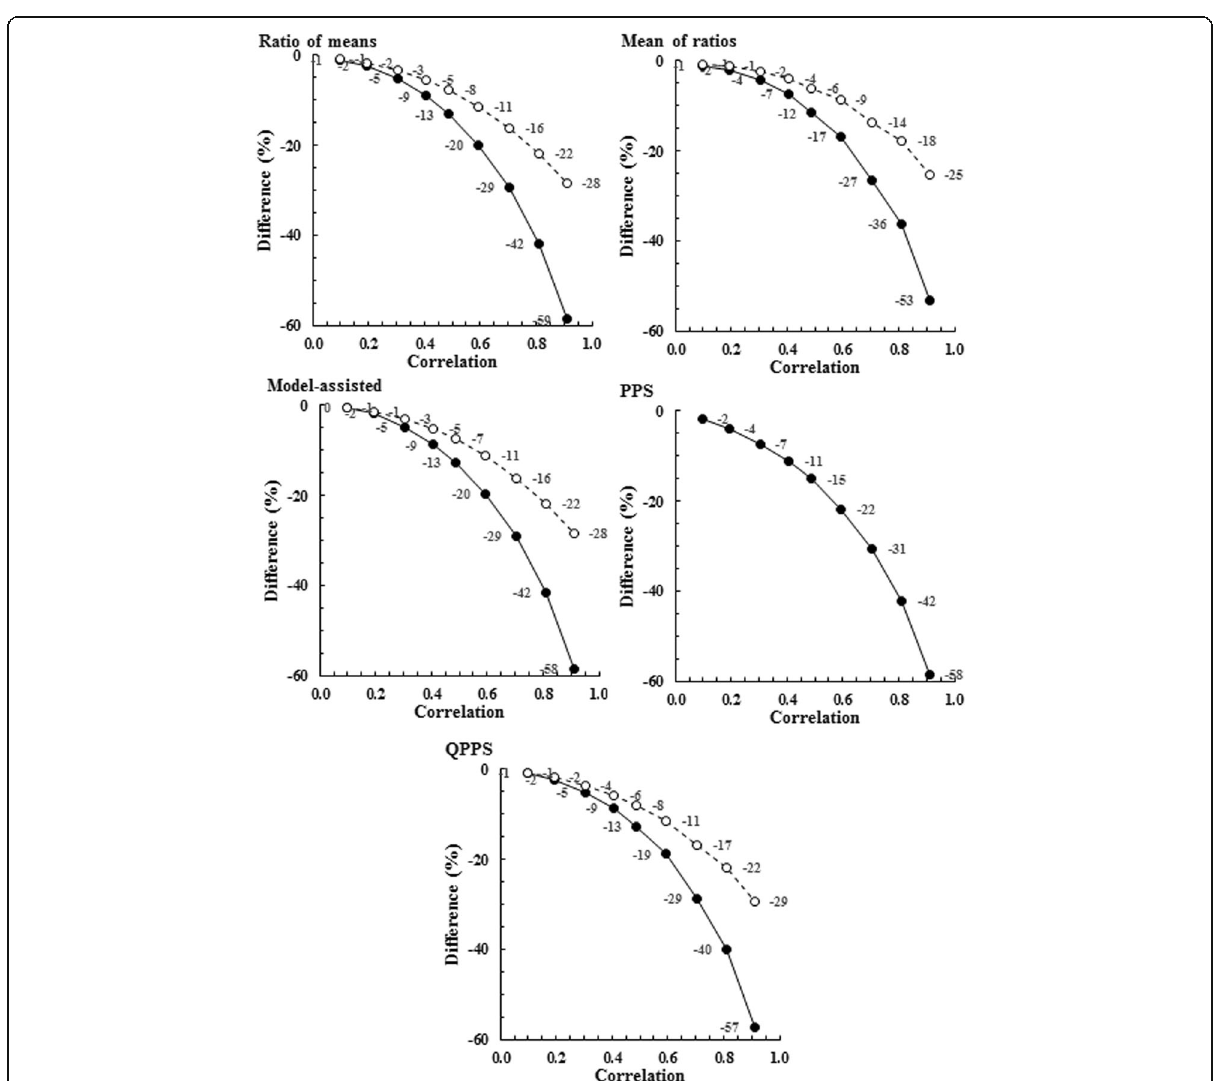
Fig. 3 Effects of target-auxiliary variable level of correlation on efficiency of the various double sampling estimators for the stand basal area of Japanese rainforest example. Scatter plots are drawn, against the target-auxiliary variable level of correlation, of the difference (%) between the mean of the simulation estimates of the standard error of estimates of the population mean for the estimator concerned and the mean of the standard error of estimates obtained when simple random sampling was used, as a proportion of the mean from the simple random sampling case. The results are for the case that the second-phase sample size was 100. Each data point is the mean of 5000 standard error estimates. Results are shown for the case that values of the auxiliary variable were available from a complete enumeration of the population ( (cid:129) ___ (cid:129) ) or for a first-phase sample size of f = 240 (O- - -O). The annotation on each data point shows the actual percentage difference for that point; values for correlation level of 0.9 there are shown also as the first line of Table